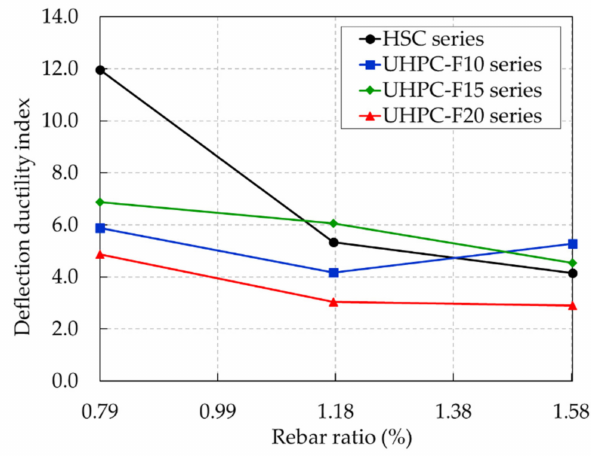
Figure 15. Deflection ductility indices of the UHPC and HSC beams with various rebar